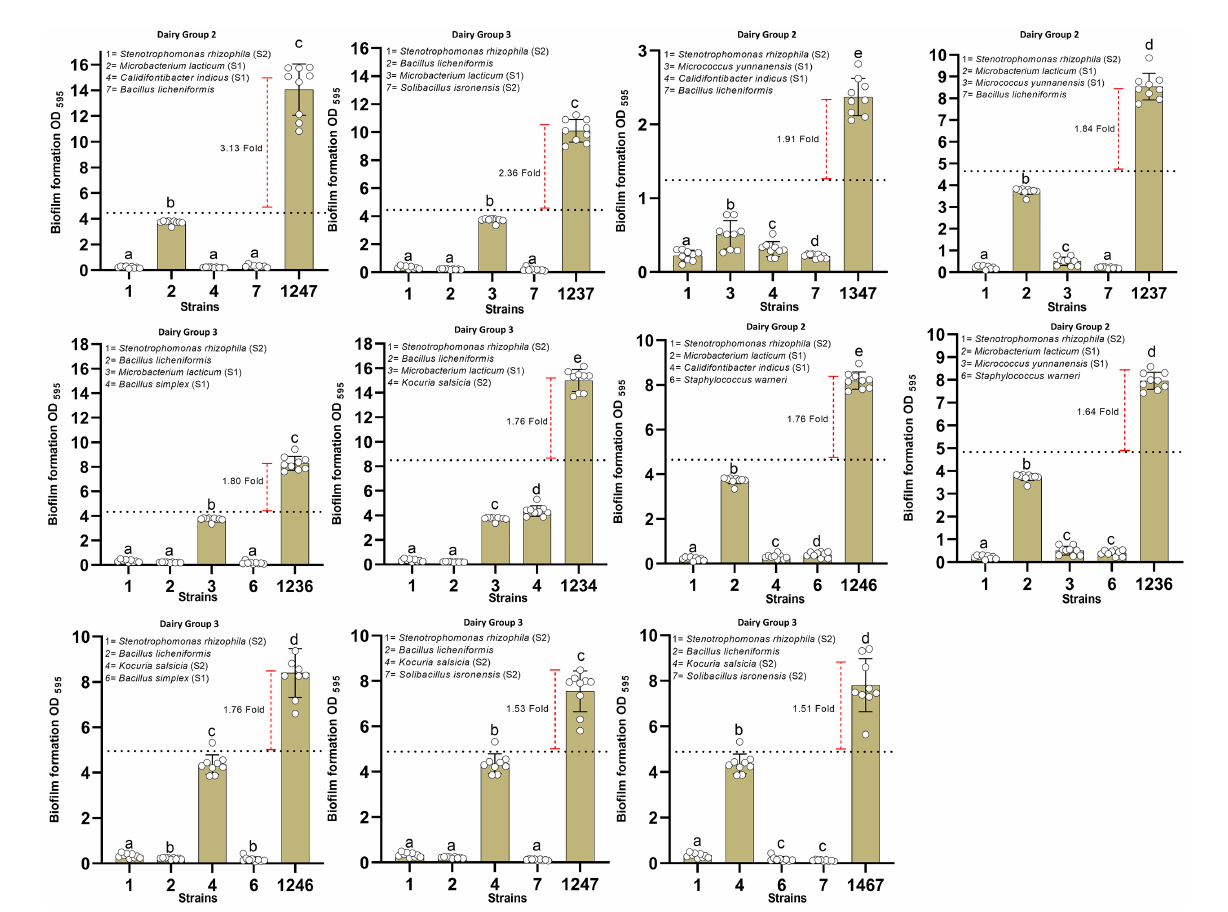
FIGURE 4 Synergistic interactions in four-species biofilm combinations of dairy strains. All four-species combinations showing pronounced synergistic interactions (at least 1.5-fold increase in biofilm mass compared with sum of biofilm masses of all strains in isolation) are shown. These 11 groups belong to two groups of the dairy strains (2 and 3). In each four-species combination, comparisons were made among the biofilm masses of single species and the mixed-species biofilm using one-way ANOVA with Duncan’s post hoc test ( p < 0.05 for